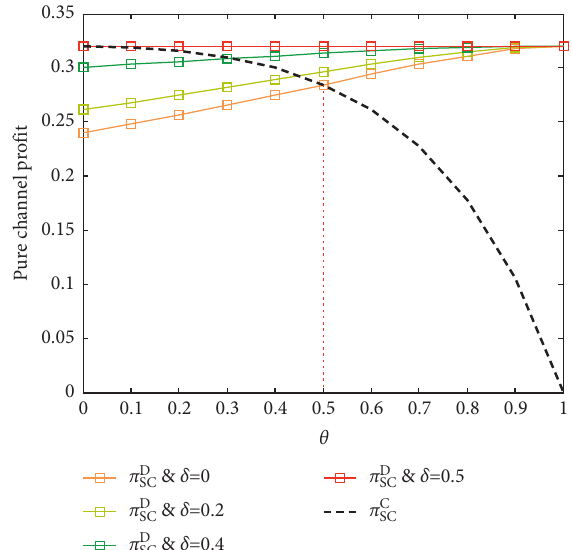
Figure 1: The joint impacts of δ and θ on the pure channel profit.